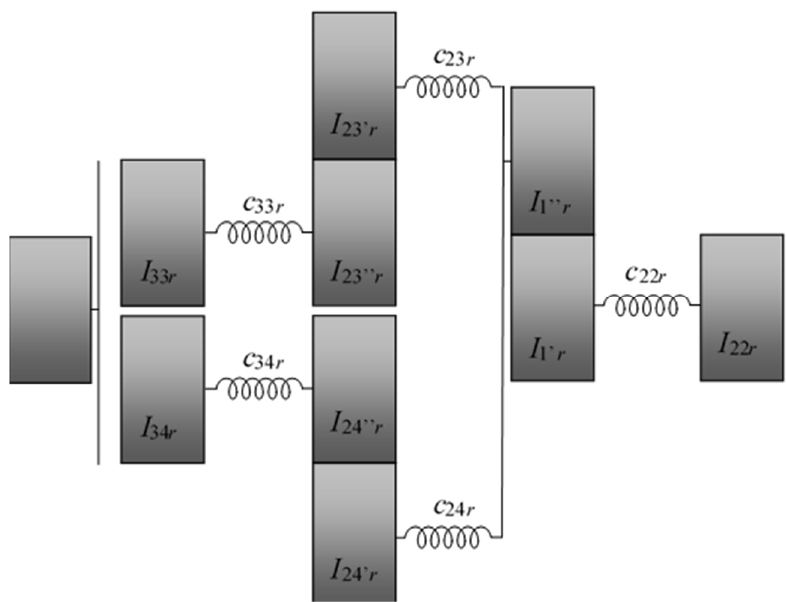
Figure 8. Model of the drive system including all the couplings.